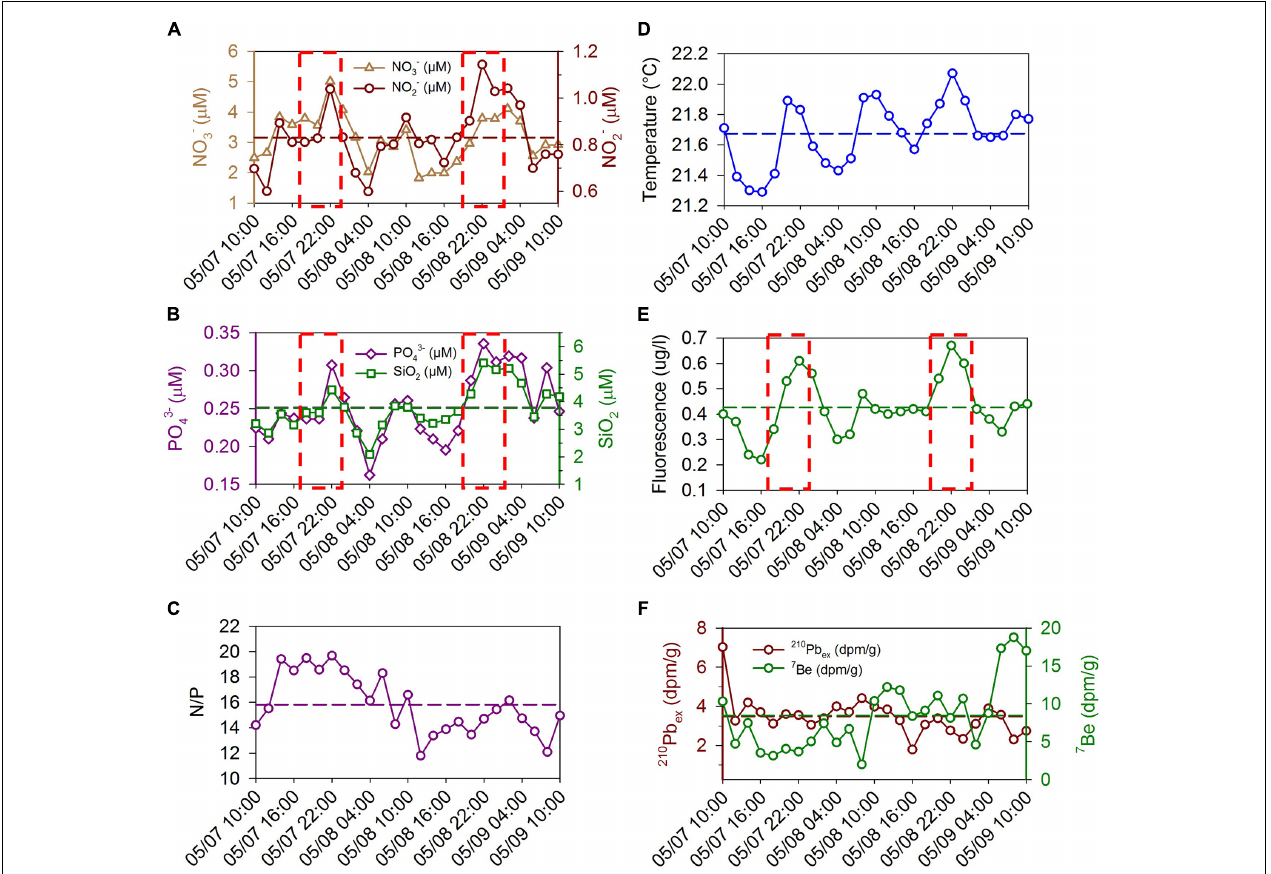
FIGURE 4 | Temporal changes of (A) nitrate and nitrite (NO 3 − , NO 2 − ); (B) phosphate (PO 43 − ) and silicate (SiO 2 ); (C) N/P ratio in the upper water column (dashed line indicates the mean value); and changes of (D) temperature; (E) fluorescence in the lower water column; and (F) 210 Pb ex and 7 Be in the surface sediment. The red rectangles correspond to the dashed red rectangles in Figures 3B,C